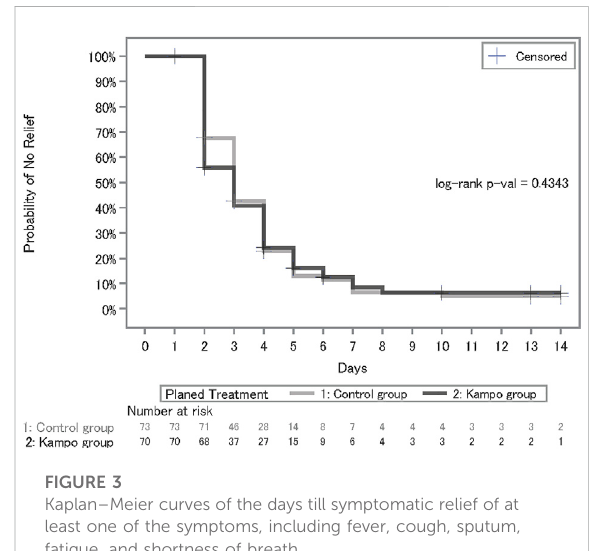
FIGURE 3 Kaplan – Meier curves of the days till symptomatic relief of at least one of the symptoms, including fever, cough, sputum, fatigue, and shortness of